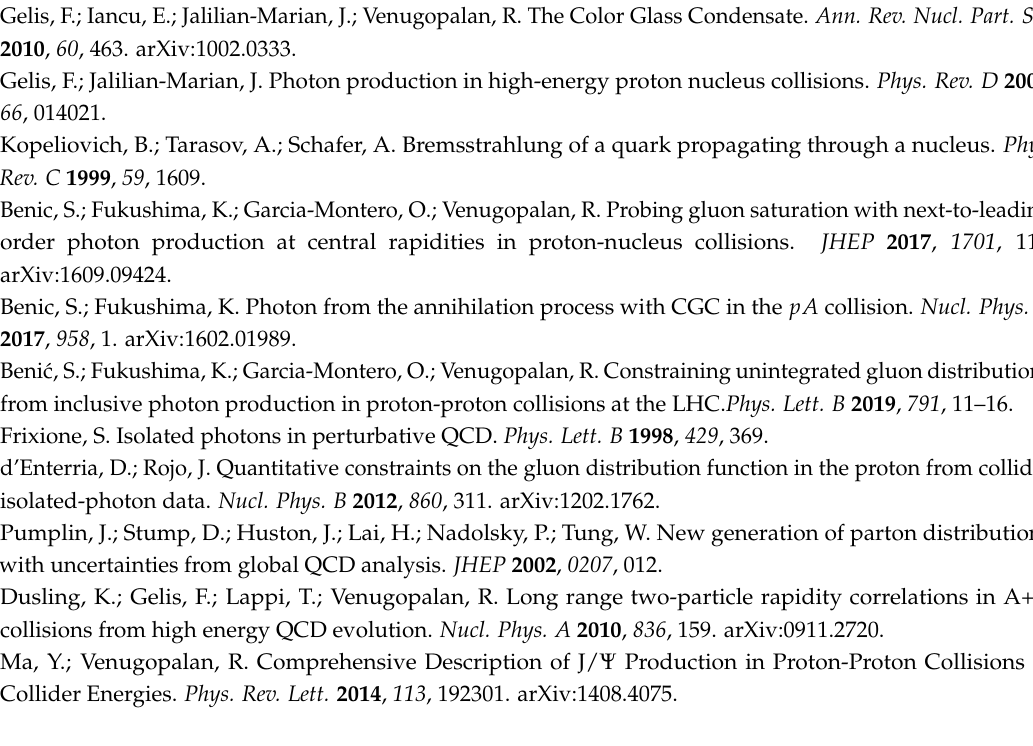
Figure 3. Comparison to the CMS and ATLAS p+p photon data at line is obtained by multiplying our numerical results with a K -factor of K = 2.4. The band represents a 15% a systematic uncertainty of our calculation across several rapidity